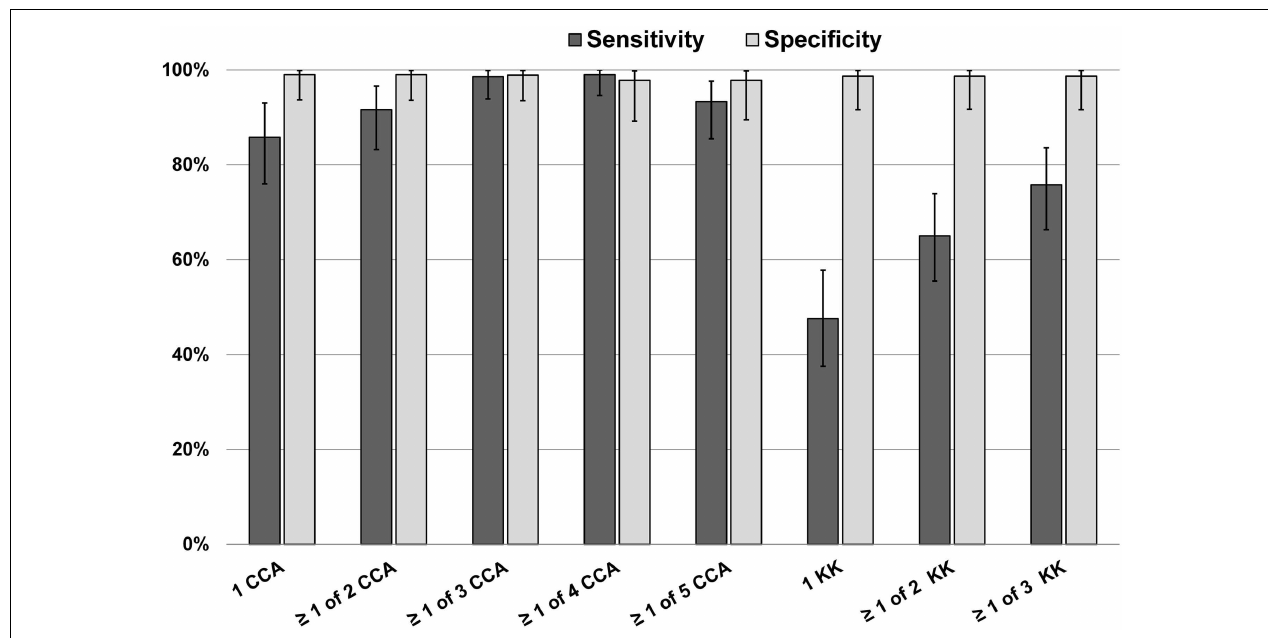
FIGURE 2 | Bayesian latent class modeling values for sensitivity and specificity of single and multiple POC-CCA tests versus one or more Kato-Katz tests, Kenya .